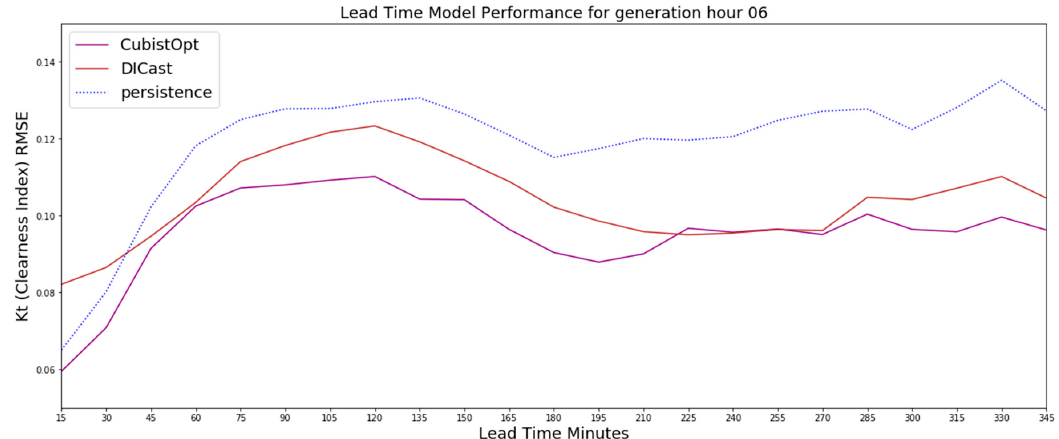
Figure A3. The 6 UTC generation time RMSE results on the test dataset for the CubistOpt method, the clearness index persistence and the DICast forecasts, which show that the CubistOpt (purple line) method has the lowest error over all time periods.